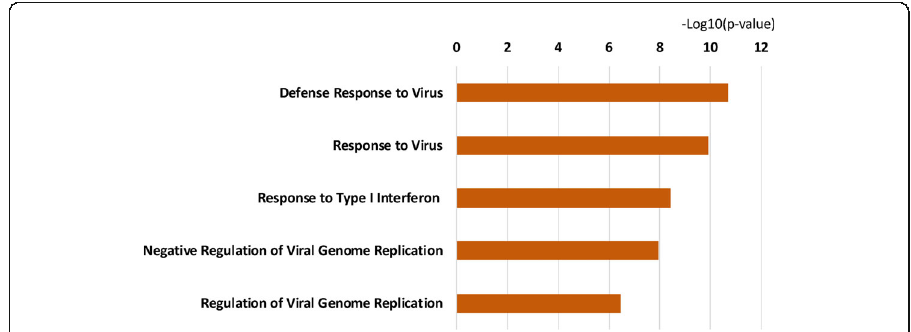
Fig. 3 Gene ontology category overrepresentation for dysregulated genes in patients with septic